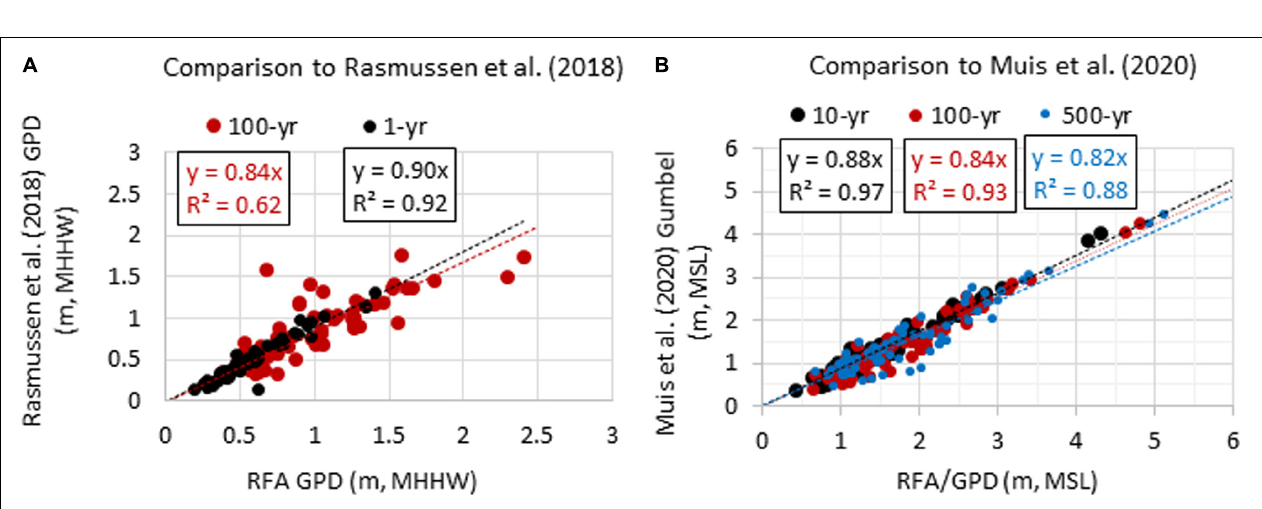
FIGURE 8 | Comparison of our RFA GPD (A) 1- and 100-year LESLs to those from a single-gauge GPD of Rasmussen et al. (2018) and (B) 10-, 100-, and 500-year LESLs to those with a Gumbel fit for global tide and surge model output of Muis et al. (2020) with linear regression fit and statistics.